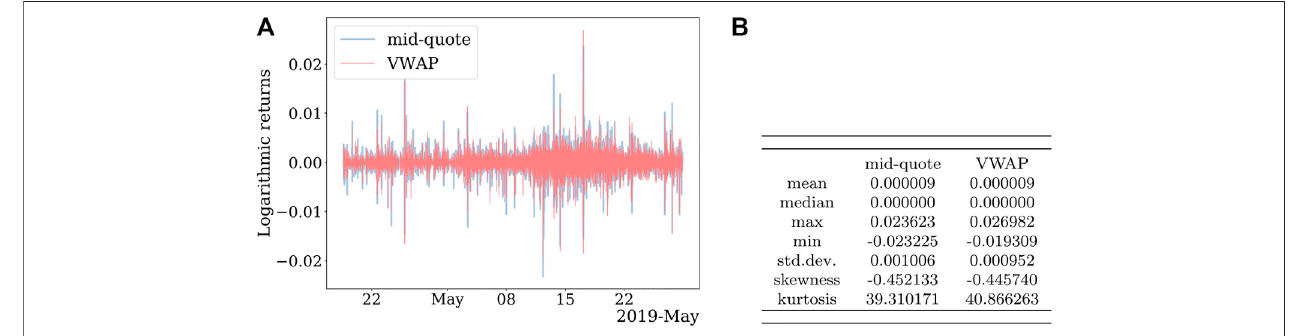
FIGURE 1 | Volume-weighted and mid-quote logarithmic returns for the Bitcoin market. (A) Time series. (B) Descriptive